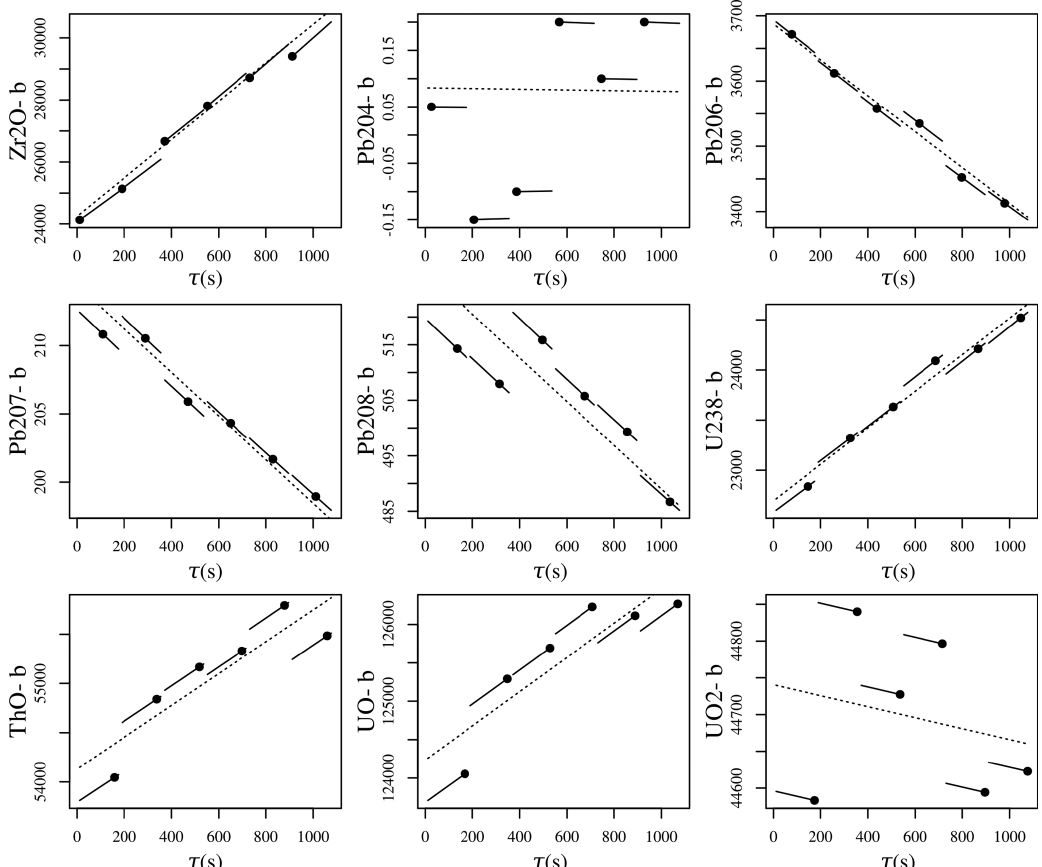
Figure 4. Within-spot drift correction of the background-corrected SHRIMP data from Fig. 3. Dotted lines are log-linear functions whose element-specific slopes ( γ X in Eq. 17) are used for the drift correction but for no other purpose. Solid lines mark the duration of each mass spectrometer cycle, with the black dots representing the starting point of each individual mass station within the cycles. The solid lines are parallel to the dotted lines (in log space) and express how the isotope ratio fits can be translated to match the asynchronous mass spectrometer signals. Vertical axes have units of counts per